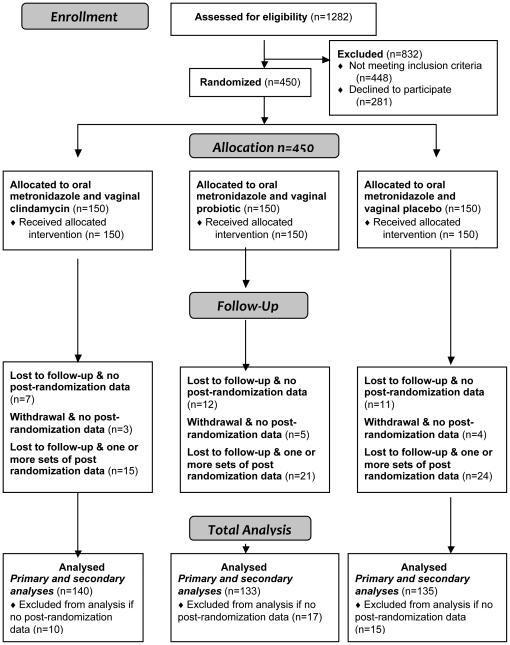
Participant Flow.